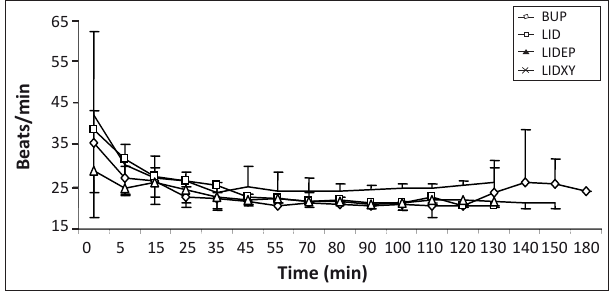
FIGURE 3 : Respiratory rate ( mean ± s.d.) in sheep ( n = 6) administered with epidural lidocaine, lidocaine-epinephrine, lidocaine-xylazine or bupivacaine